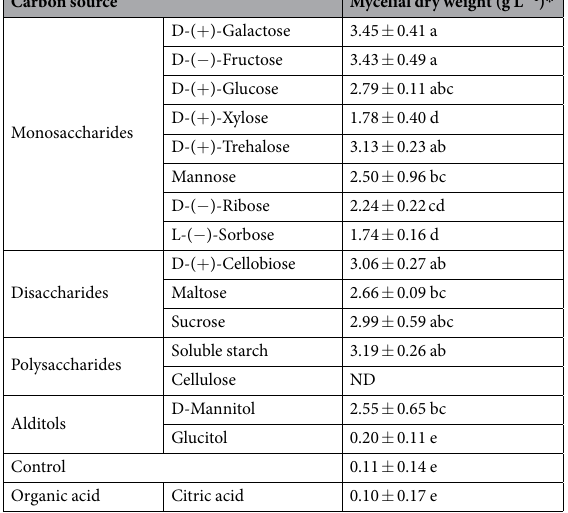
Table 6. Effect of carbon source on the mycelial growth of Isaria farinosa . * Mean ± SE. Values followed by the same letters within a column do not differ significantly (ANOVA, P = 0.05).